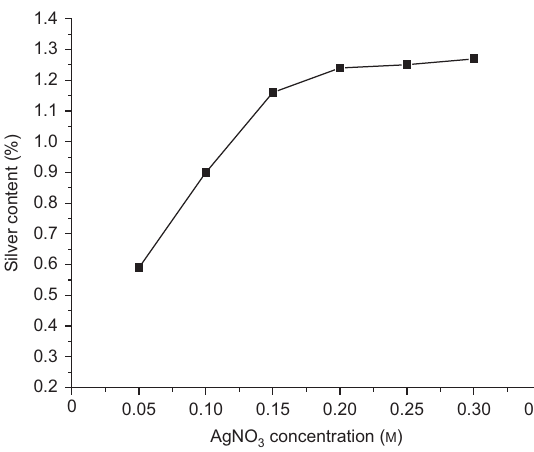
concentration on the silver content of 3